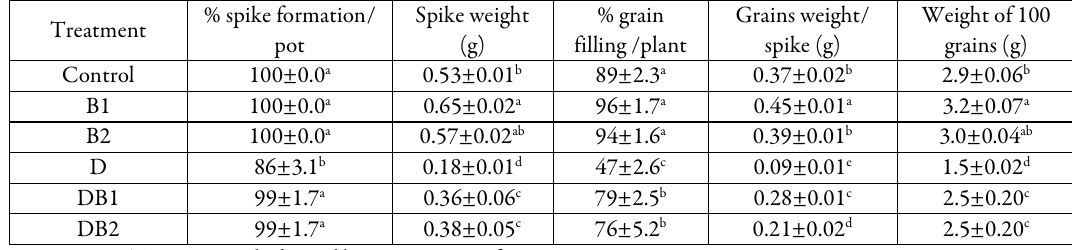
Table 2. Effect of bacterial inoculation with A. brasilense NO40 (B 1 ) and S. maltophilia (B 2 ) on the yield criteria of Triticum aestivum (cv. ‘G9’) plants grown in sandy soil, under unstressed (irrigated every 5 days) and drought-stressed (irrigated every 10 days) conditions. Treatments means of 3 sets, each set contained 3 replicas (± SD). Cont. = the unstressed-uninoculated treatment; D=drought-stressed-uninoculated treatment, B (1-2) = the unstressed-inoculated treatments and DB (1-2) = the drought stressed-inoculated